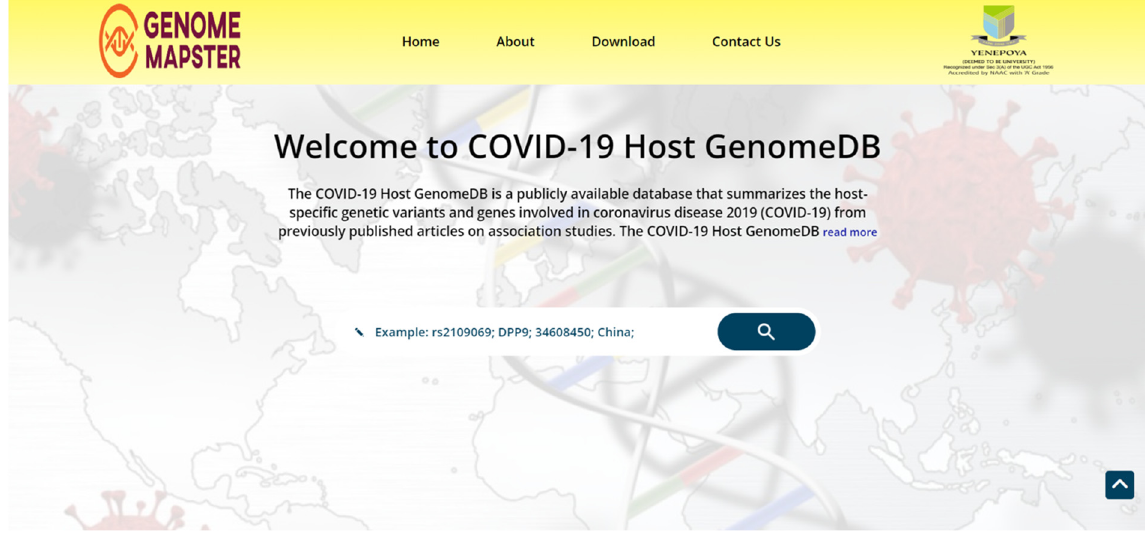
Figure 1. The snapshot of the main page of COVID-19 Host GenomeDB. This website contains four sections: home, about, download, and contact us. In the search box, users search by the reference single nucleotide polymorphism cluster ID, gene, ID (reference number of the article), or population.